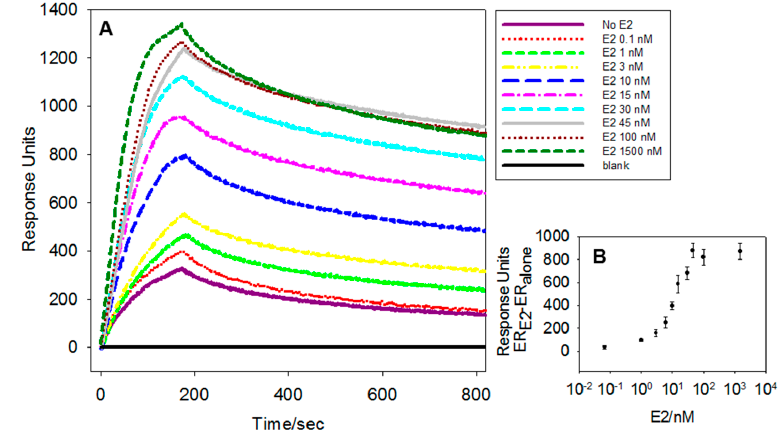
Figure 2. ( A ) Surface plasmon resonance (SPR) sensorgrams of the interaction between 134 nM wt-ER α LBD with different E2 concentrations (0.1, 1, 3, 10, 15, 30, 45, 100, 1500 nM); ( B ) The SPR signal recorded 60 s after the injection and is plotted as a function of E2